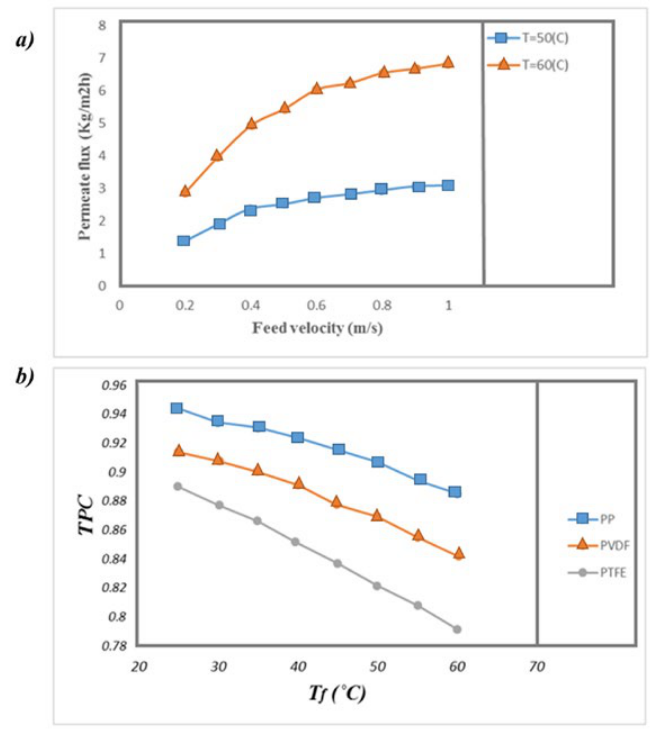
Fig. 6: a) Effect of the velocity of seawater feed on the distillate flux, b) Effect of feed temperature on the temperature polarization.